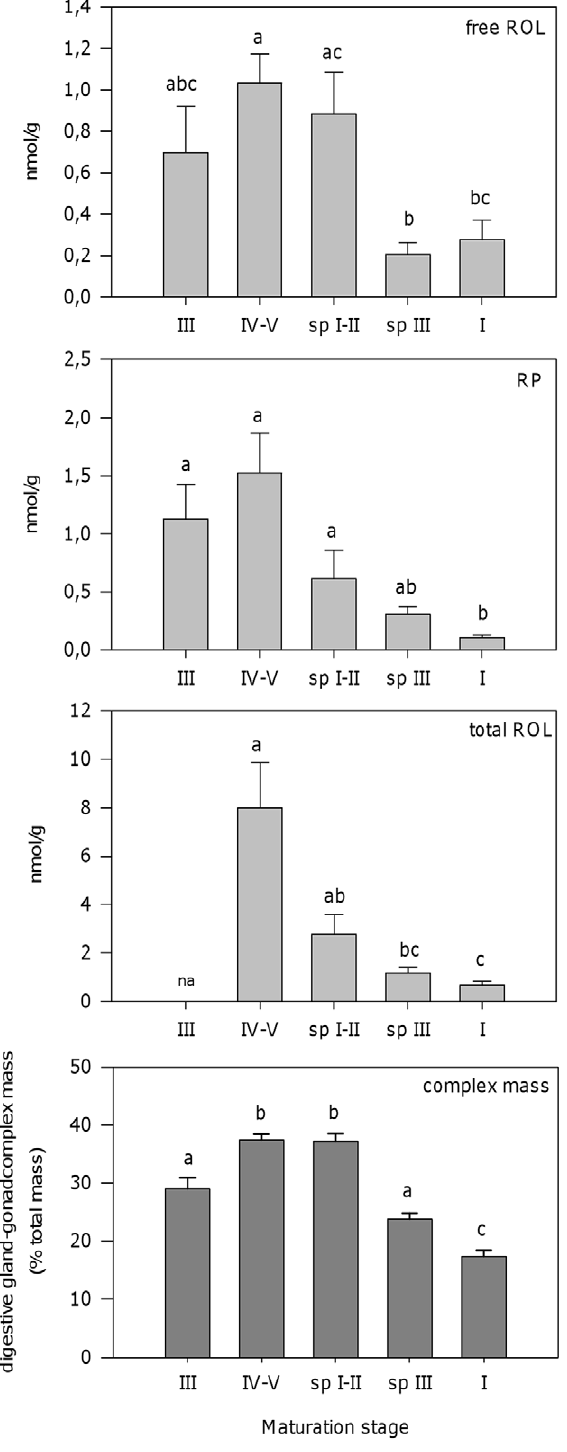
Figure 3. Retinoids in the digestive gland-gonad complex of Osilinuslineatus . Free retinol, retinyl palmitate and total retinol (free